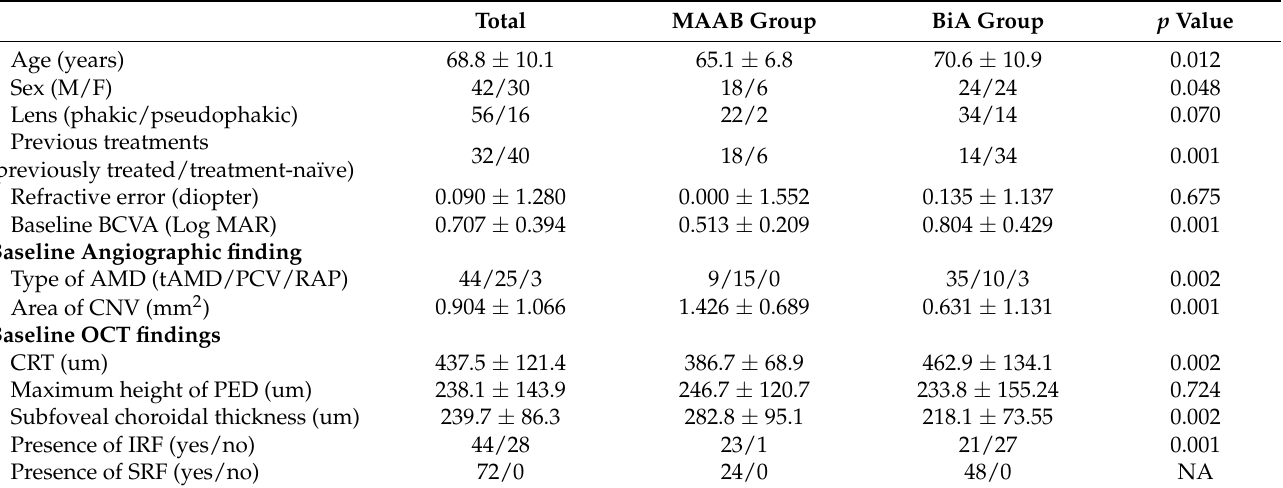
Table 1. Demographics and baseline characteristics.